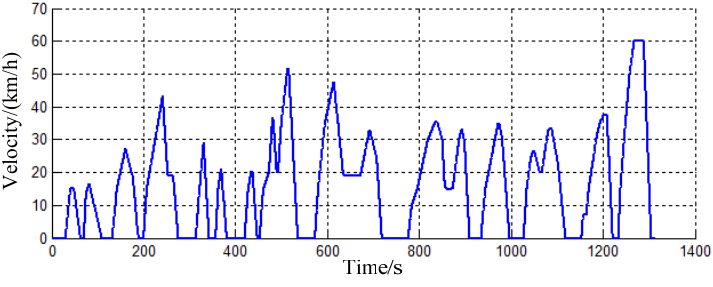
Figure 16. Velocity profile of the CSUDC cycle.